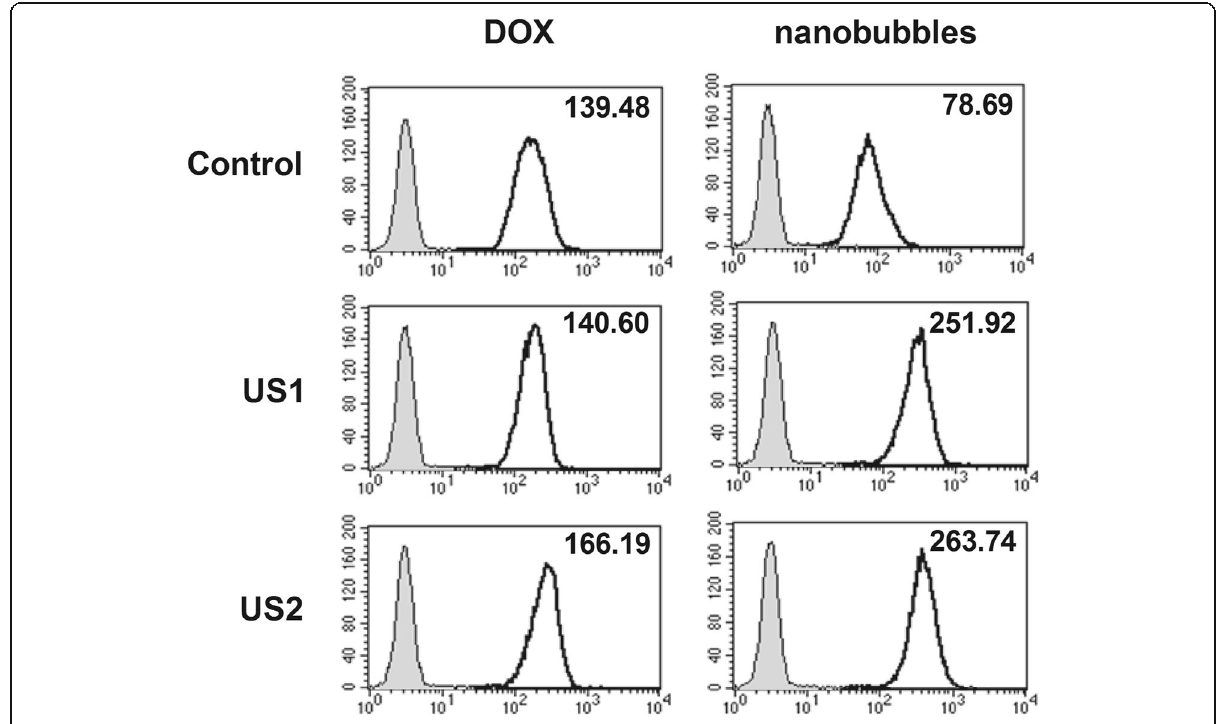
Fig. 7 Flow cytometry analysis of DOX delivery in MCF-7 cells by DOX-loaded NBs (US1 0.5 W/cm 2 30 s, US2 0.5 W/cm 2 60 s)